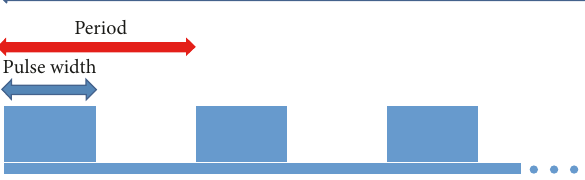
Figure 4: Continuous flash